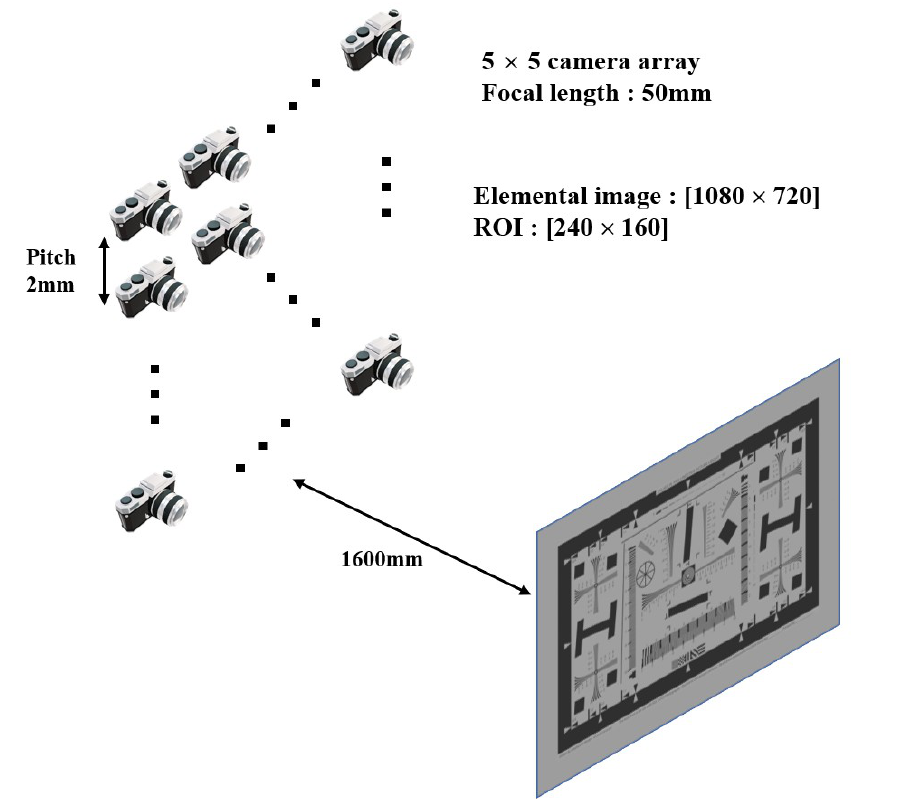
Figure 5. Simulation